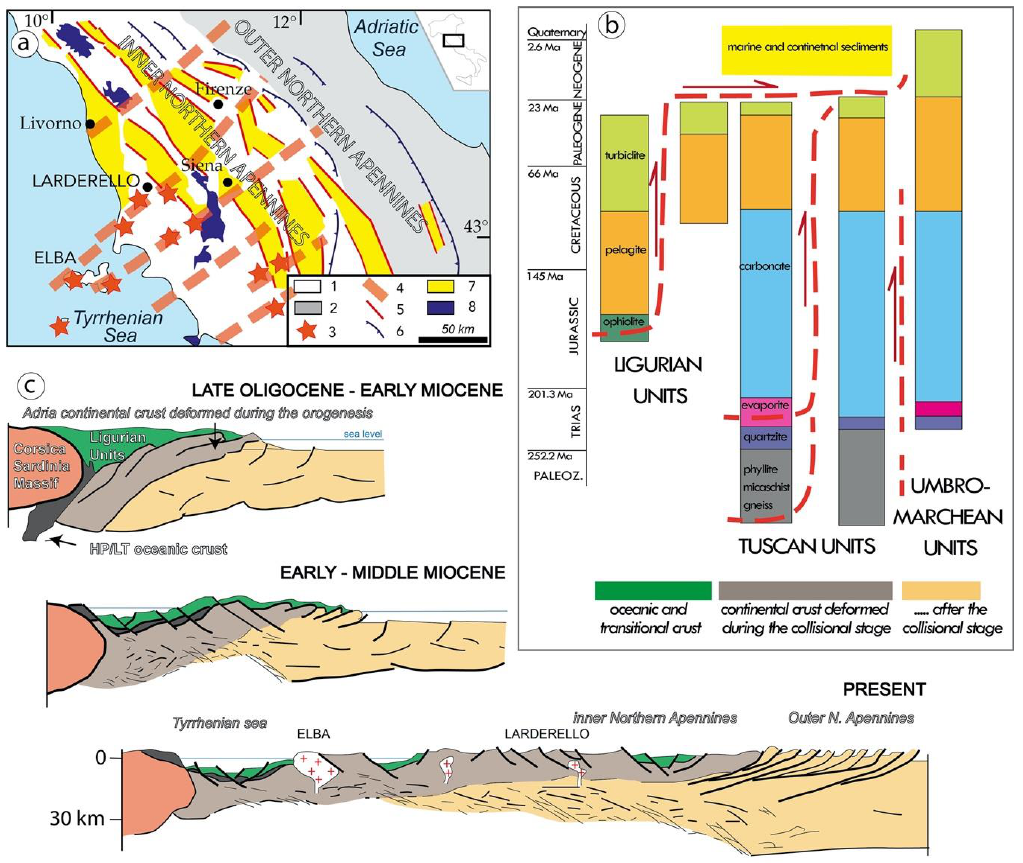
Figure 6. Geological sketches and map illustrating the evolution of Northern Apennines: ( a ) Structural sketch map showing the relationships between the main Pliocene-Pleistocene basins and transfer zones in Tuscany. Symbols: 1-inner Northern Apennines: this domain is characterized by a 22–24 thick crust; 2-outer Northern Apennines with a 35–40 thick crust; 3-Outcropping or drilled magmatic bodies; these are mainly located along the transfer zones (after References [59,60]); 4-transfer zones; 5-normal faults; 6-thrusts; 7-Pliocene-Pleistocene marine to continental sediments; 8-metamorphic rocks; ( b ) relationship between the different tectonic units of inner northern Apennines and related paleogeographic domains. ( c ) Schematic geological cross-sections showing the collisional and post-collisional evolution in the inner zone of the northern Apennines (after References [60,61]).